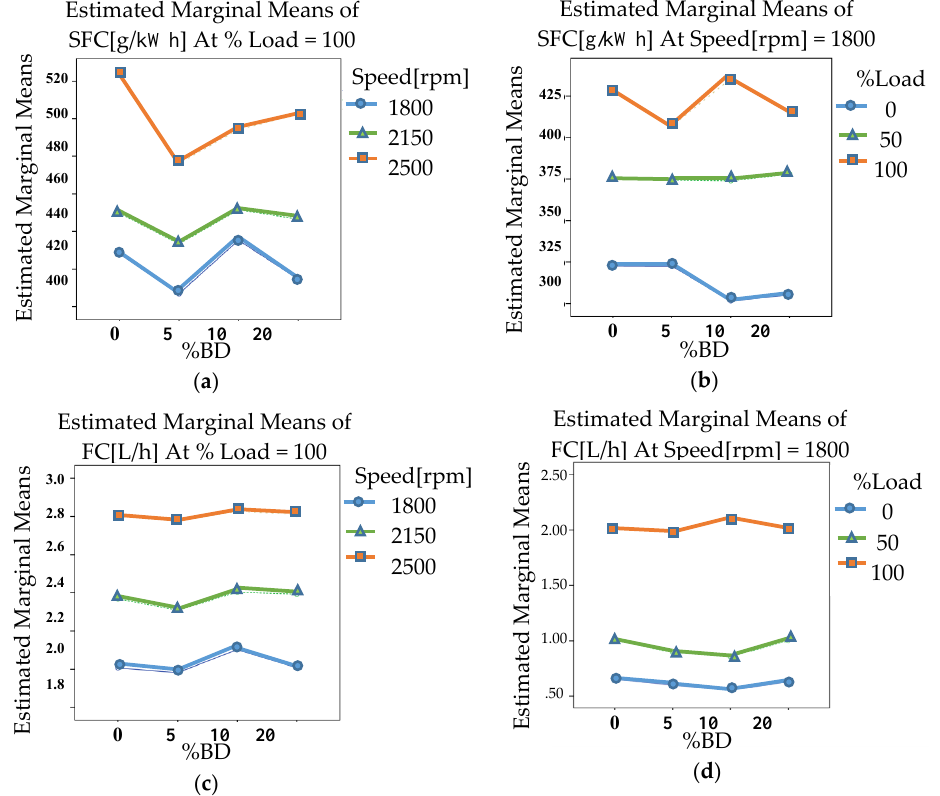
Figure 4. SFC ( a , b ) and FC ( c , d ) changes at constant load and engine speed.